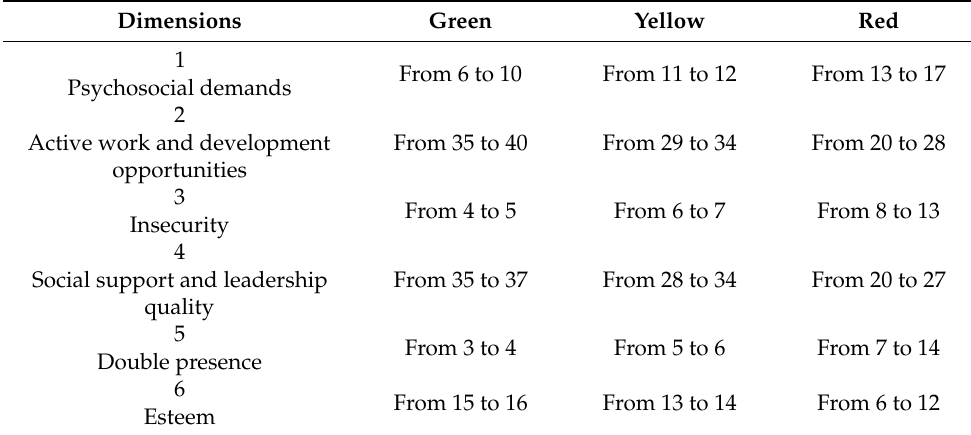
Table 5. Levels of the sections that make up the Psychosocial Risk Assessment Questionnaire in Non-Formal Contexts according to risk area in points. Dimensions Green